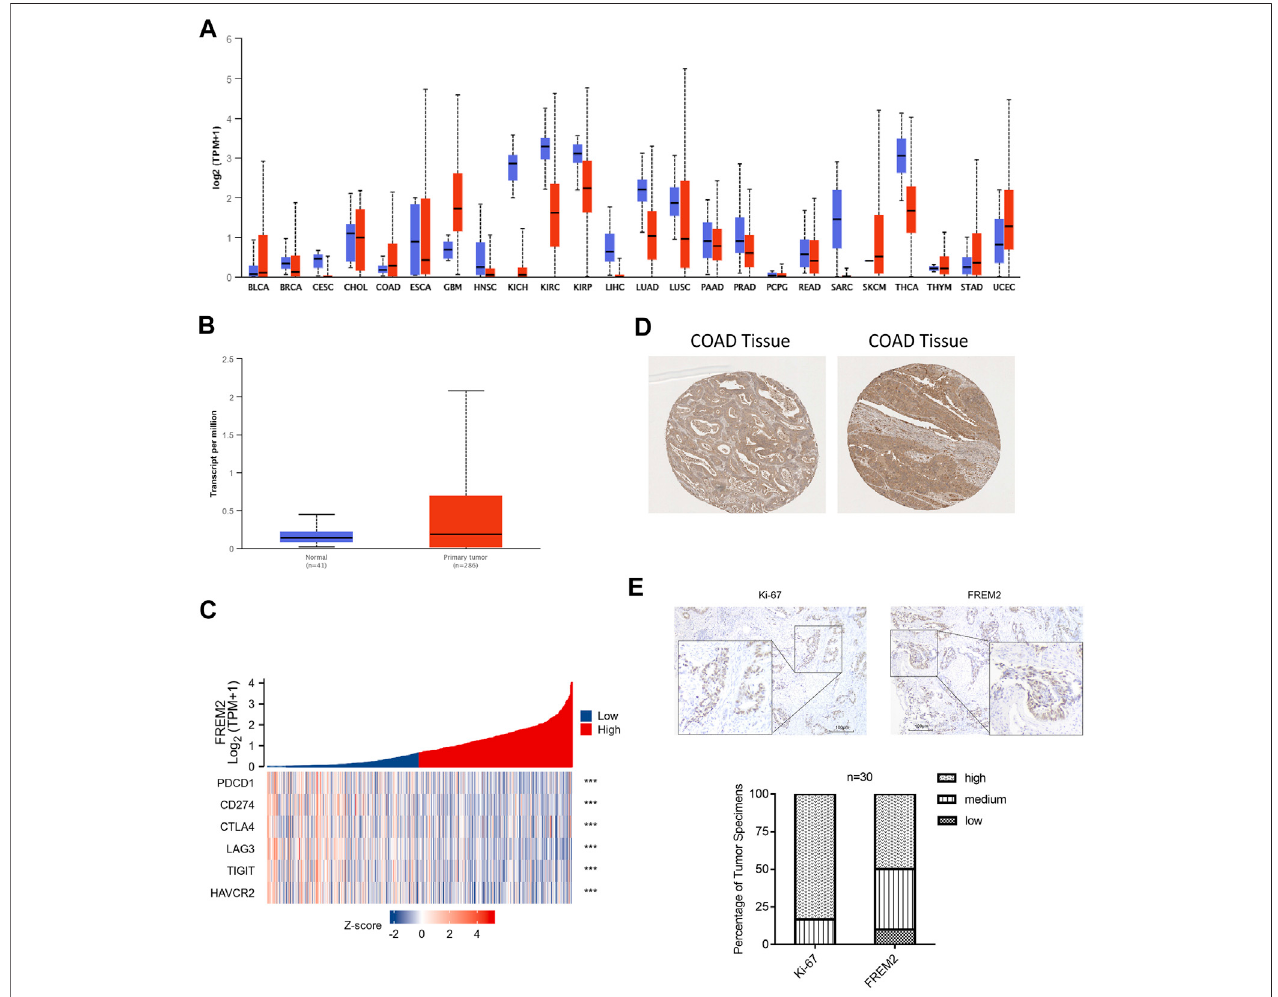
FIGURE 9 | FREM2 expression analysis. Expression of FREM2 in pan-cancer, using UALCAN database (A) . The expression of FREM2 in colon adenocarcinoma (COAD),usingthedatafromTheCancerGenomeAtlasdatabase (B) .Correlation analysisof FREM2 andimmunecheckpoints,displayedusingaheatmap (C) .Analysis of FREM2 expression levels in COAD tissues, using the Human Protein Atlas (HPA) database (D) . High expression levels of Ki-67 and FREM2 were presented in colorectal cancer tissues ( n = 30) by immunohistochemistry (IHC) staining. (E) Histogram of the results of analysis of IHC staining. Original magni fi cation is ×100 (inset: IHC stain, DAB, original magni fi cation is